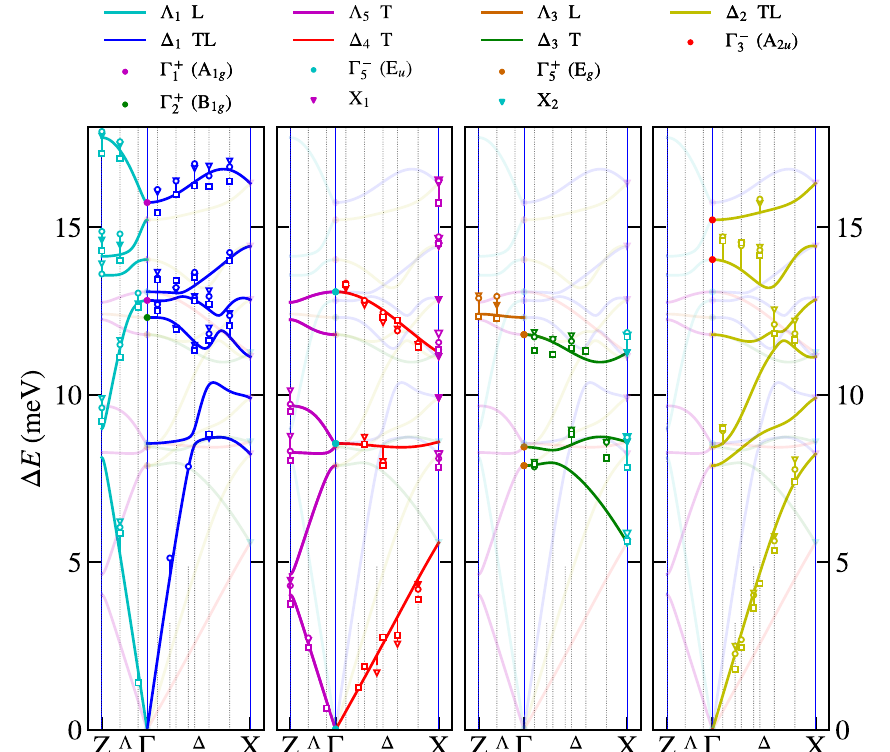
Figure 6. The comparison of theoretical calculation with the fit of measured inelastic X-ray scattering spectra for CePd 2 Al 2 in energy range 0 - 17.5 meV. The (cid:31) , ○ , ▽ symbols correspond to 1.5, 7.5, 280 K, respectively. For details of the fit, see chapter Results – Phonon dispersion curves in (Ce,La)Pd 2 Al 2